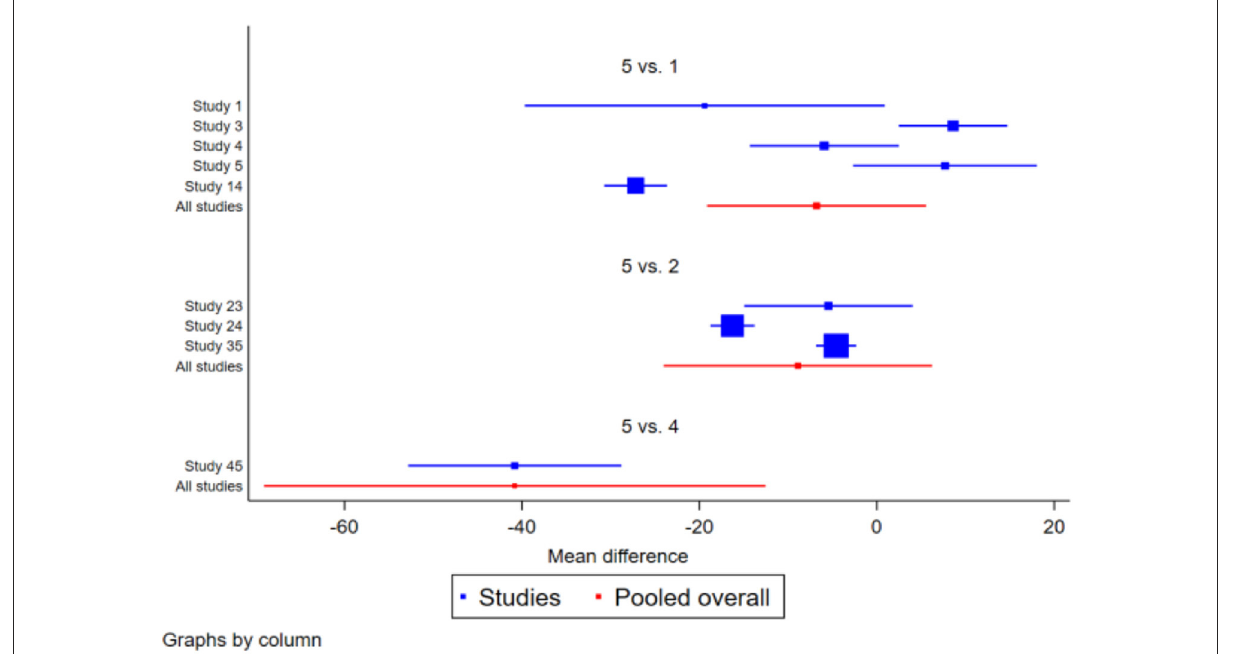
FIGURE9 Forest plot of the effect of traditional Chinese exercise treatment on MFES in the elderly.